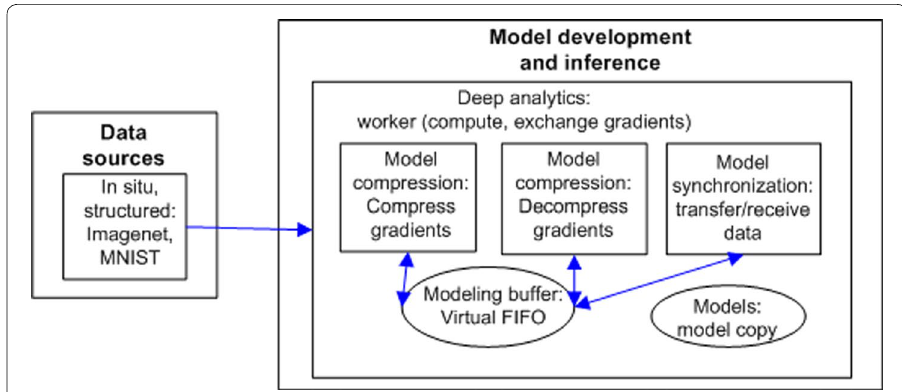
Fig. 17 The mapping of network accelerated distributed DNN learning [39] to the big data RA